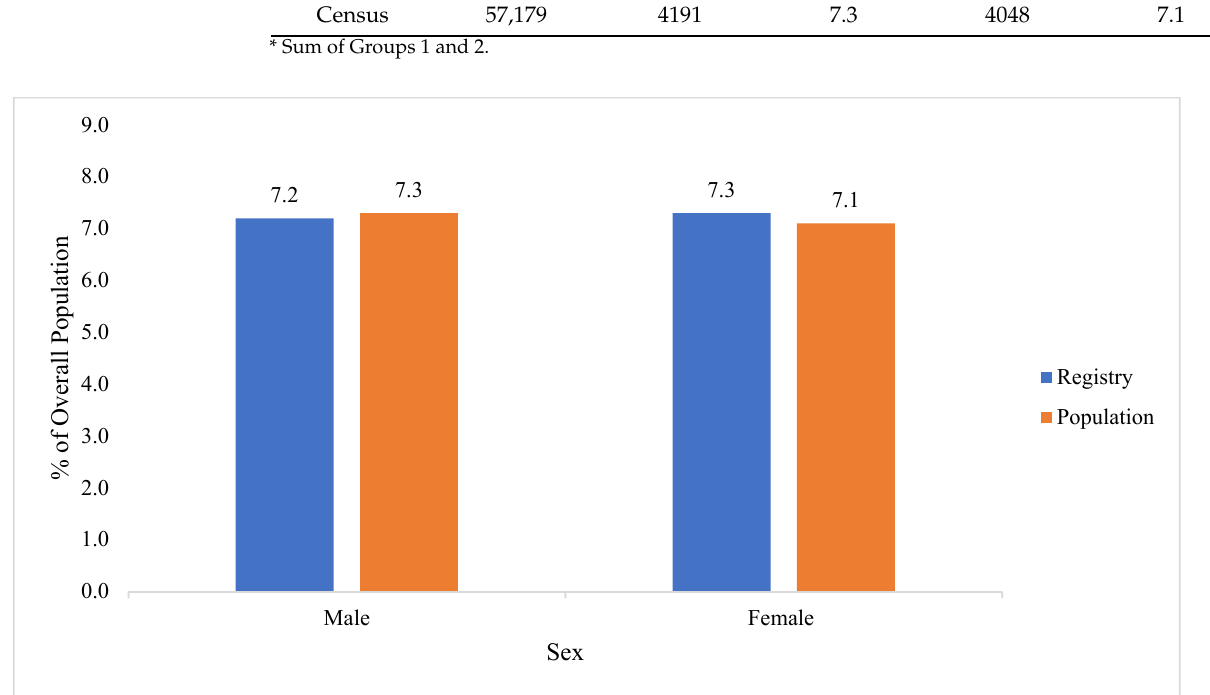
Figure 4. Comparison of proportions by sex of WTCHR (Registry) resident children to population south of Canal Street in Lower Manhattan in 2000.